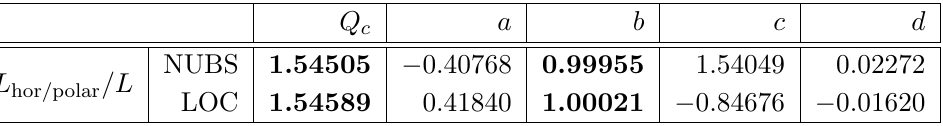
Table 2 . Critical exponent and other parameters obtained from the (cid:12)t of the NUBS’s horizon length (1st row) and LOC’s polar length (2nd row).